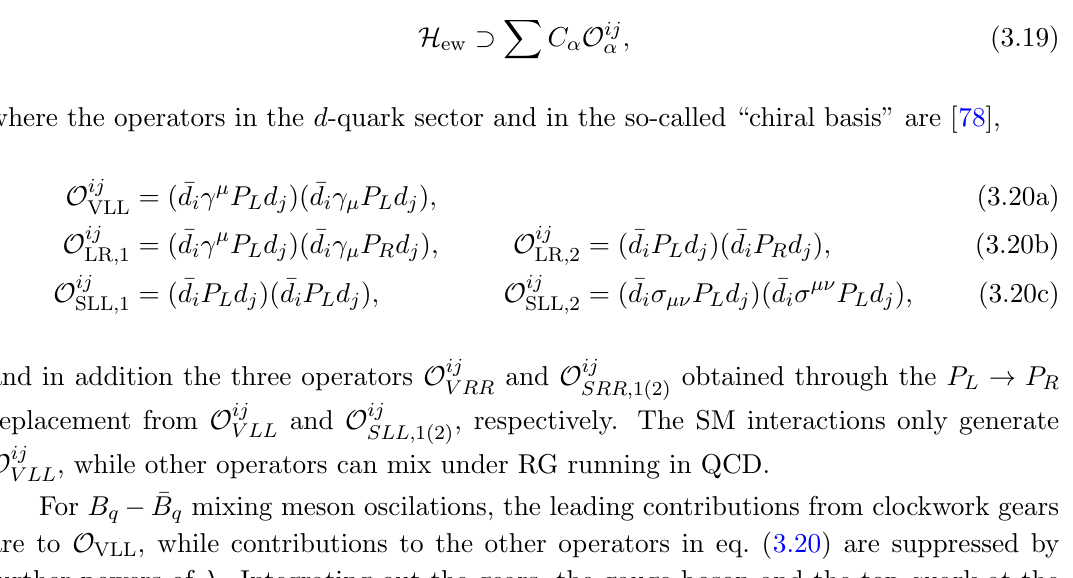
Figure 12 . Diagrams contributing to neutral-meson mixing at tree-level and by two insertions of 2 H 2 D